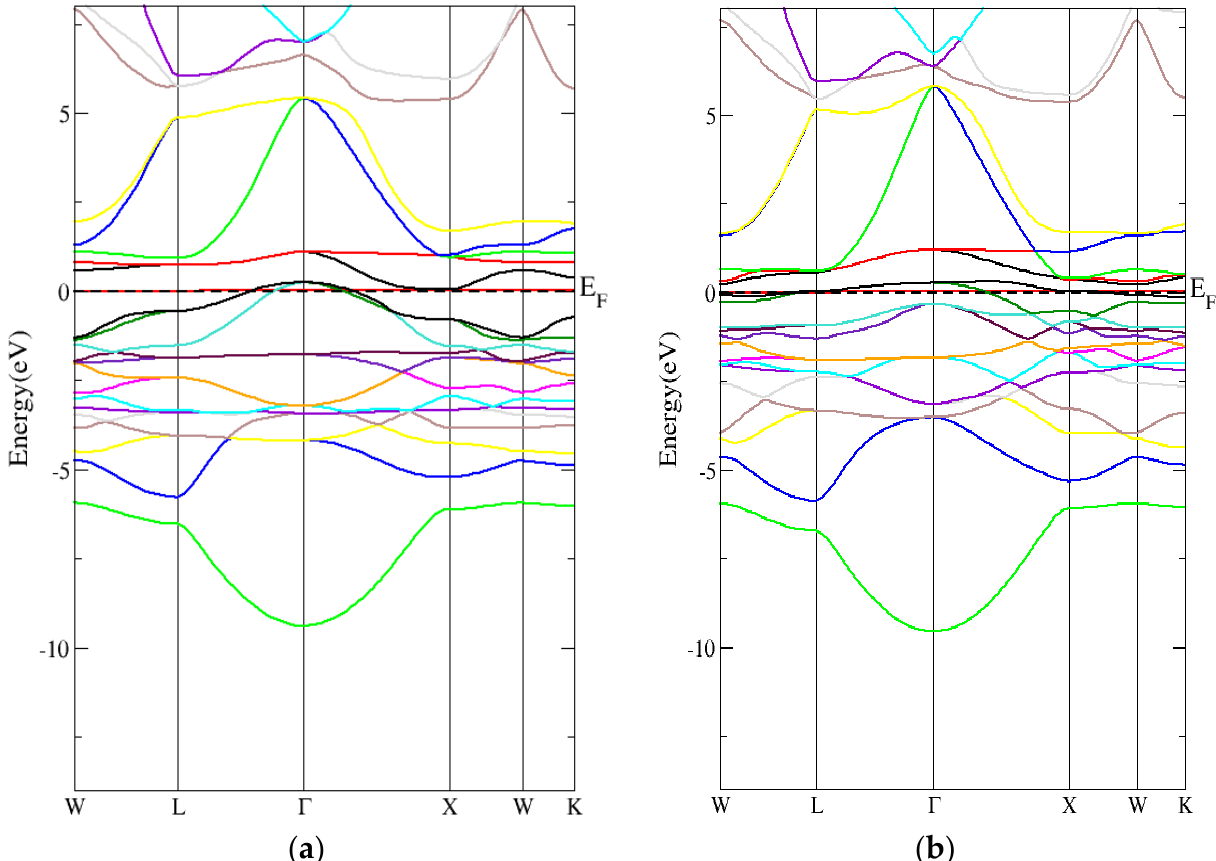
Figure 5. The band structure for the inverse Heusler Co 2 CrAl compound by employing the mBJ-GGA technique for ( a ) spin-up inverse Heusler Co 2 CrAl compound ( b ) spin-down inverse Heusler Co 2 CrAl compound.